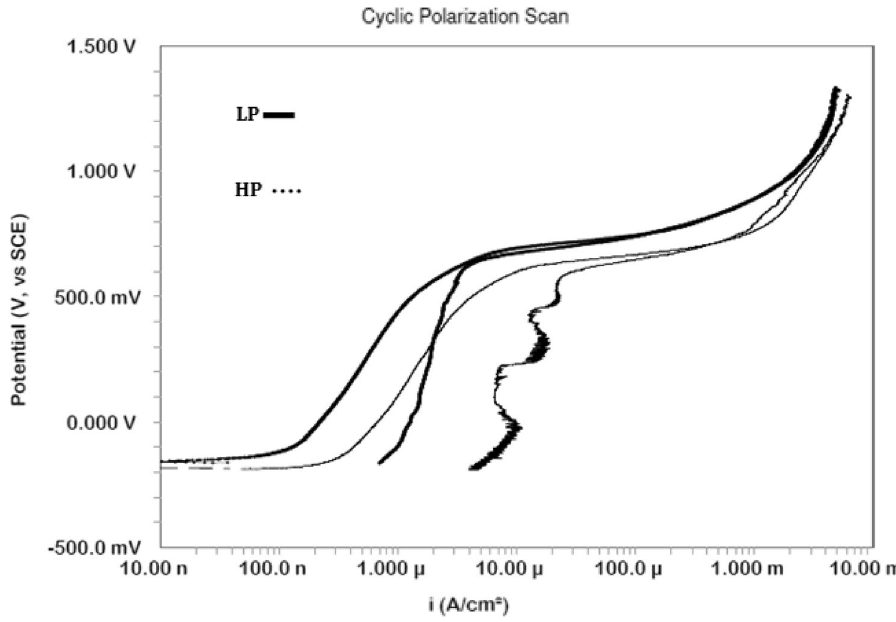
Figure 8. Cyclic polarisation of HP and LP steel bars after 1700 h of their exposure in chloride free